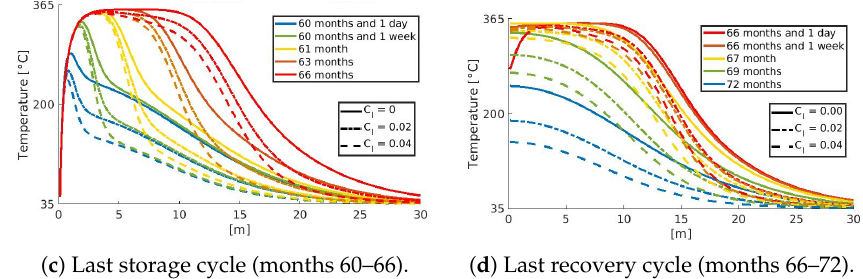
Figure 4. The temperature distribution along the diagonal section of the aquifer for different times. Storage cycles: ( a , c ). Recovery cycles: ( b , d